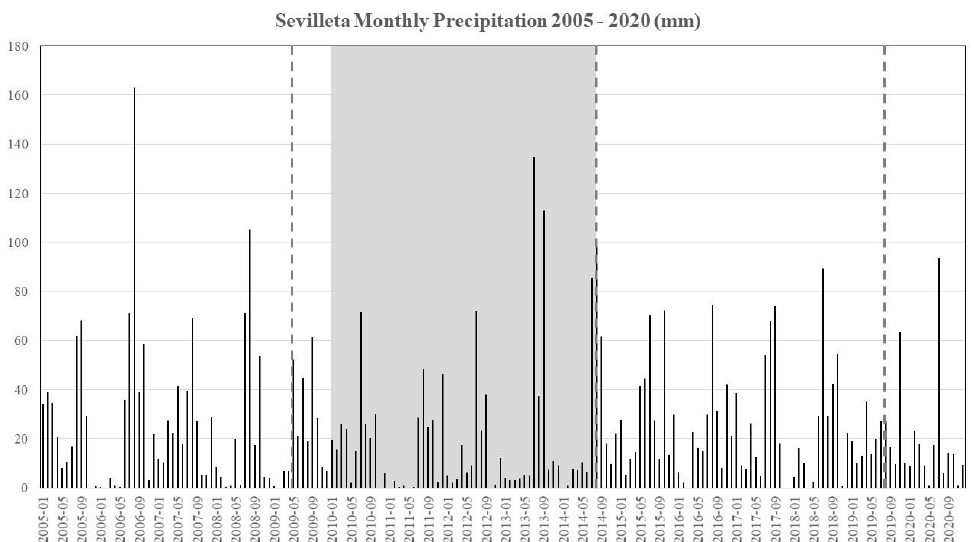
Figure 2. Monthly precipitation at the SNWR with the drought period as defined by the NOAA National Integrated Drought Information System shaded in grey. Landsat image dates used for MESMA are indicated with dashed grey lines. Precipitation data from Oregon State PRISM Climate Group.